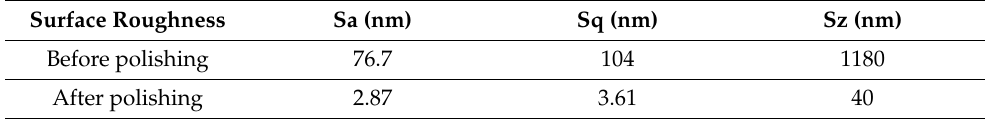
Figure 8. Surface morphology and roughness of Ti-6Al-4V workpiece after polishing. ( a ) Two-dimensional surface topography with measuring area of 1.5 mm × 1.15 mm; ( b ) two-dimensional surface topography with measuring area of 0.5 mm × 0.5 mm; ( c ) three-dimensional surface topography with measuring area of 0.5 mm × 0.5 mm; ( d ) surface roughness results. Table 3. Areal rugosity of the Ti-6Al-4V workpieces before and after